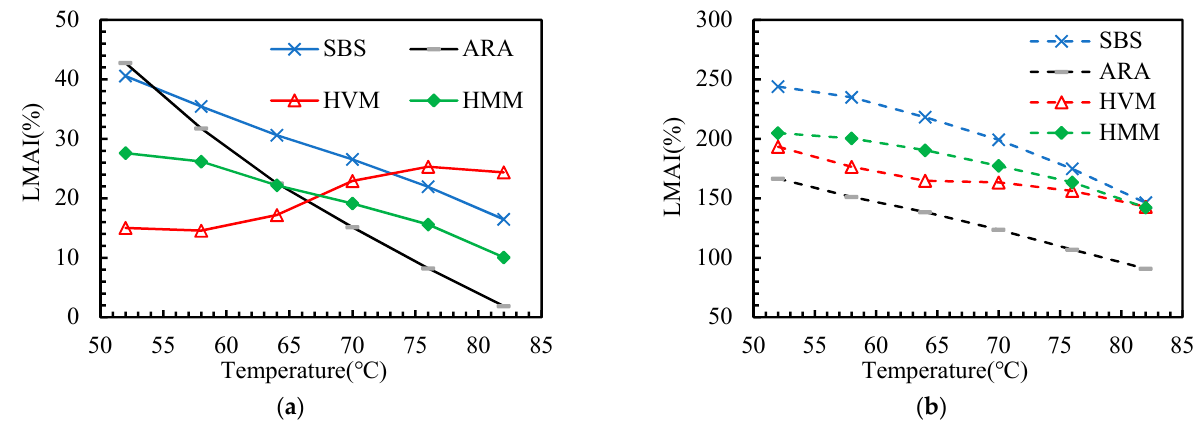
Figure 10. Loss Modulus Aging Indicator (LMAI) of the asphalt binders after aging: ( a ) TFOT; ( b ) PAV.